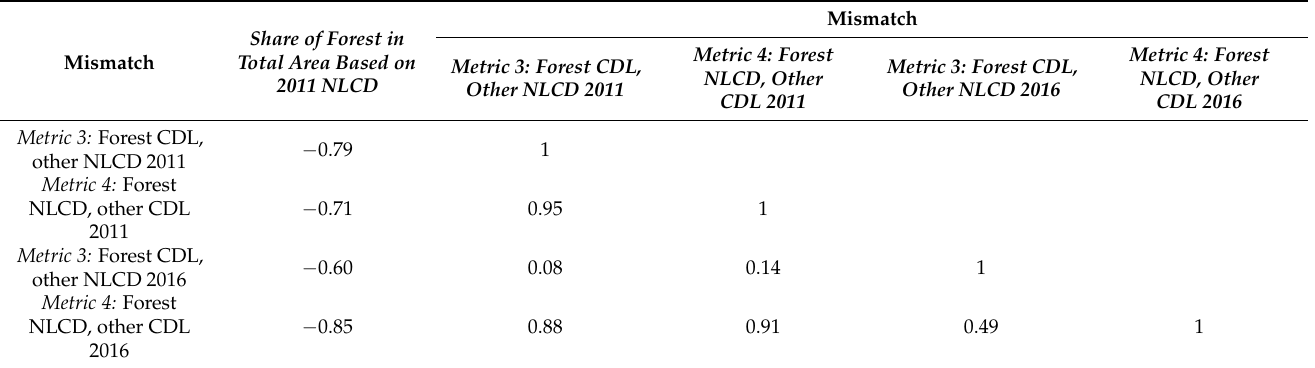
Table 5. Correlation table showing the relationship between the share of forests and forestland